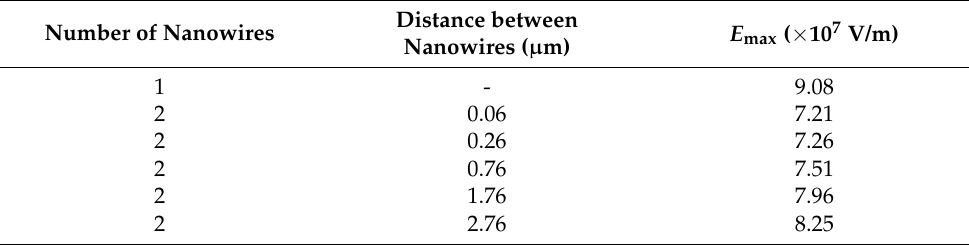
Table 2. The maximum electric field intensity E max at the tips of the nanowires.